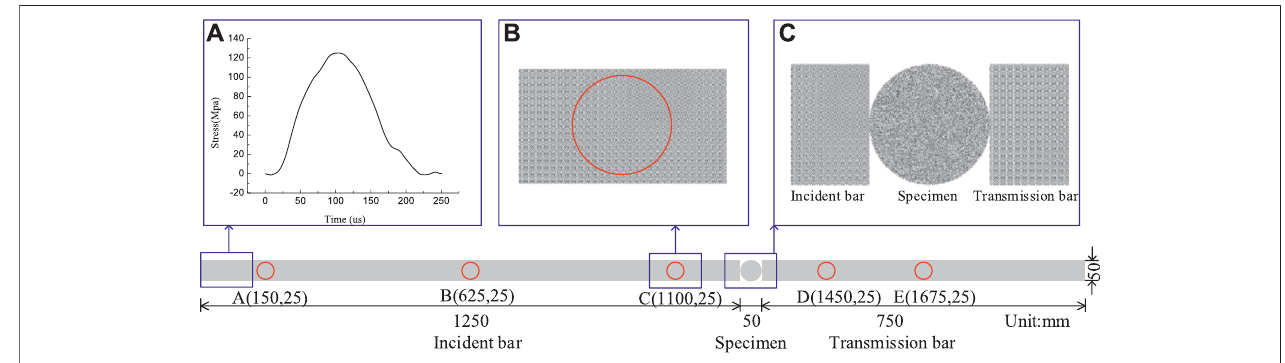
FIGURE 1 | The model of SHPB for dynamic tensile simulation. (A) The incident stress wave in simulation and experiment; (B) measure circles on the bars of this model; (C) the details of the specimen sandwiched between the incident and transmitted bars.